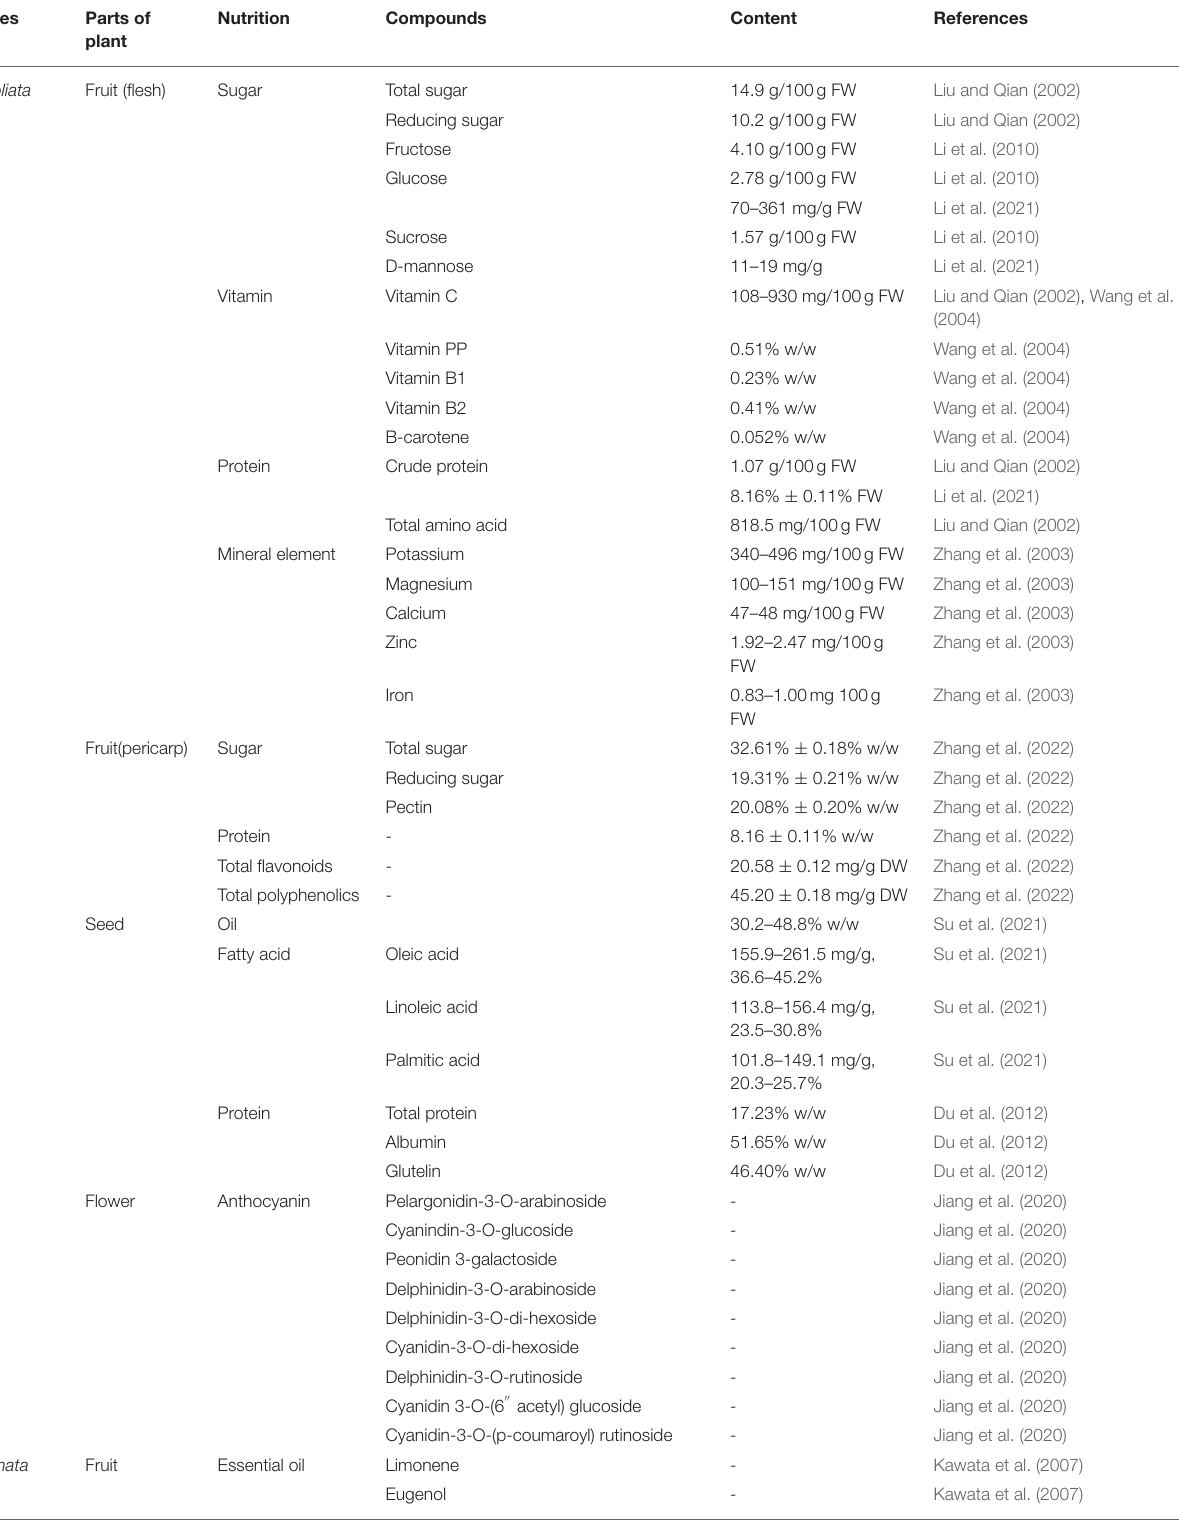
TABLE 2 | Main nutrient components in Akebia plants.